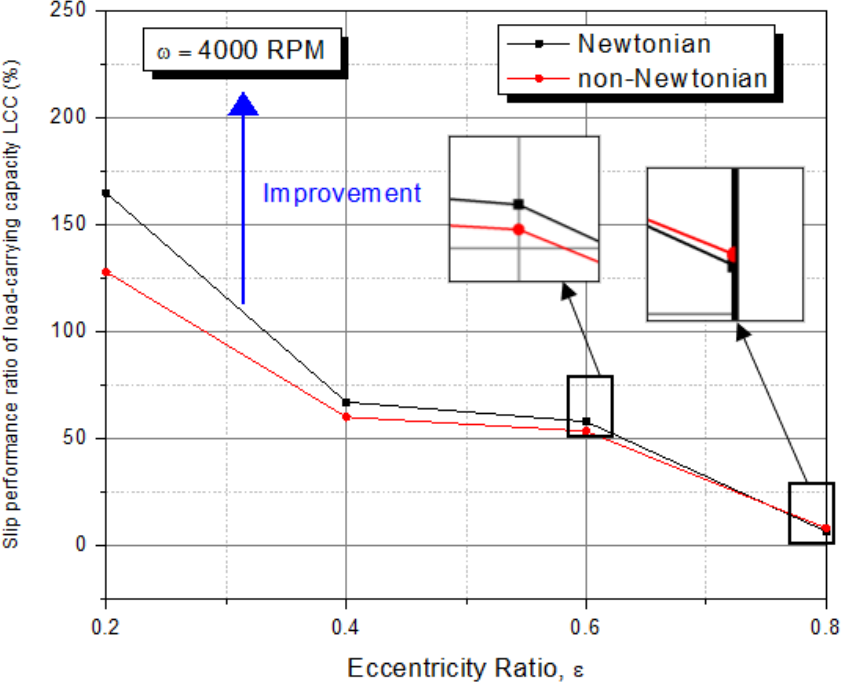
Figure 11. Schematic diagram of a heterogeneous slip/no-slip journal Figure 11. Slip performance ratio of load-carrying capacity (LCC) for several eccentricity ratios (cid:3013)(cid:3004)(cid:3004) Partial Slip (cid:2879)(cid:3013)(cid:3004)(cid:3004) No-Slip × 100% ). ( 𝑆𝑃𝑅 = (cid:3013)(cid:3004)(cid:3004) No-Slip